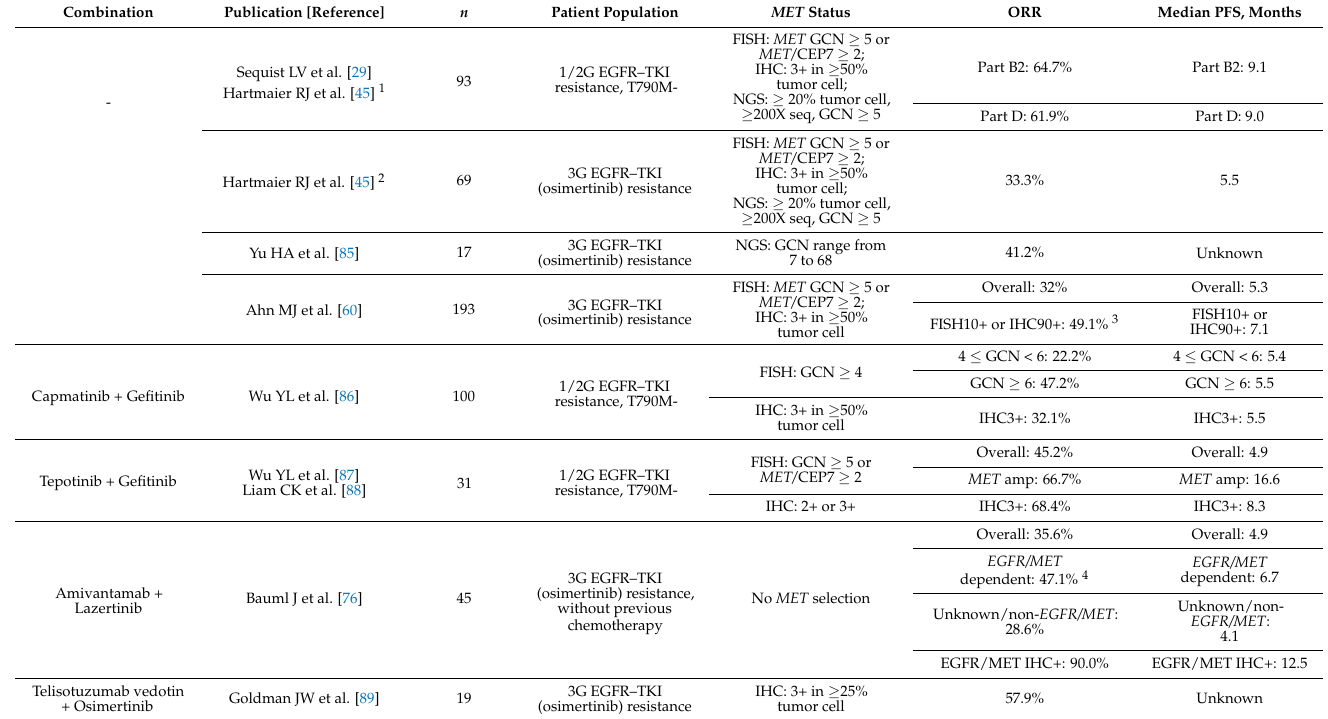
Table 6. Summary of key data after EGFR–TKI resistance with secondary MET alterations treated with combination